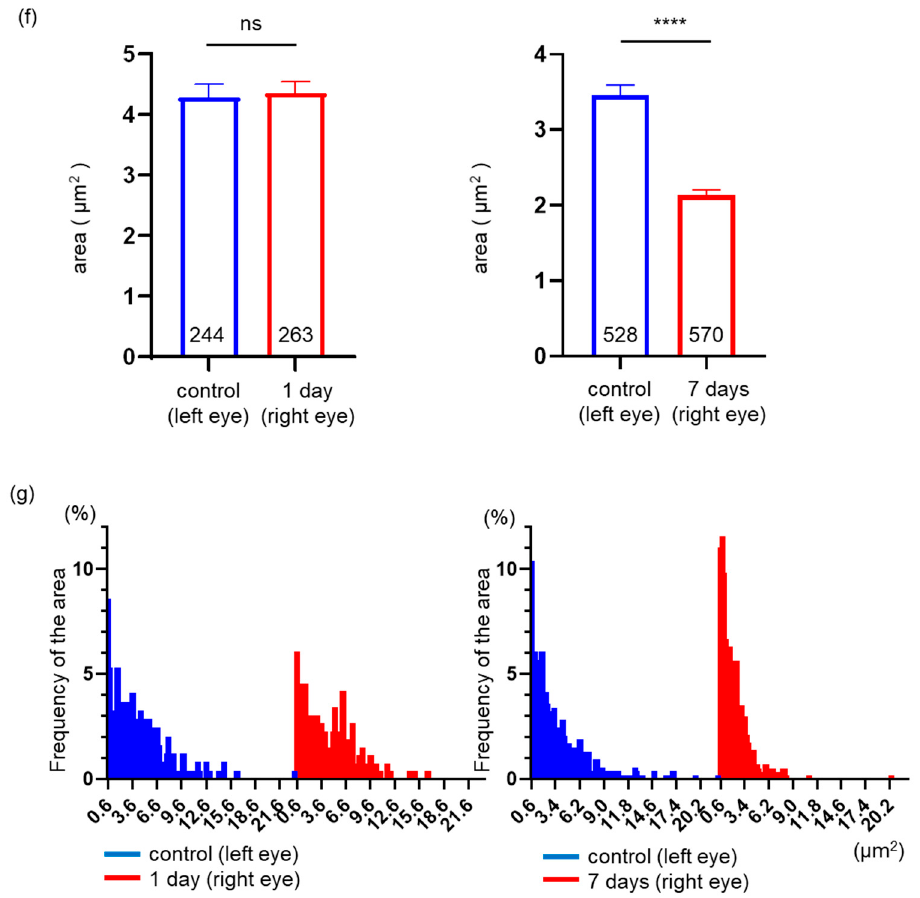
Figure 3. Visualization of YFP signals in the flat-mounted retinal section and mitochondrial distribution. ( a ) Image at low magnification. Mitochondria (YFP) shown in green. Bar, 200 μ m. Left panel: control; middle panel: 1 day; and right panel: 7 days after ONC. ( b ) Image at high magnification. Mitochondria (YFP) shown in green. Bar, 20 µ m. Each arrowhead indicates a single mitochondrion within a single axon. Left panel: control; middle panel: 1 day; and right panel: 7 days after ONC. ( c ) Mitochondria visualized within a linearized axon. Mitochondria (YFP) shown in white. Bar, 10 µ m. Upper panel: control; middle panel: 1 day; and lower panel: 7 days after ONC. YFP: yellow fluorescent protein; ONC: optic nerve crush. ( d ) Plotting of the I δ index against compartment width. All the graphs indicate that the pattern of mitochondrial distribution was uniform. The number of retinas used for quantification in each group is indicated in the graphs. Data are presented as the mean ± SEM. ( e ) The average density of mitochondria in the axons. The number of axons used for quantification in each group is indicated in the graphs. Data are presented as the mean ± SEM. *** p < 0.001, ns = not significant. ( f ) The average area of mitochondria in the axons. The number of mitochondria used for quantification in each group is indicated in the graphs. Data are presented as the mean ± SEM. **** p < 0.0001, ns = not significant. ( g ) Frequency distribution of the average area of the mitochondria in the